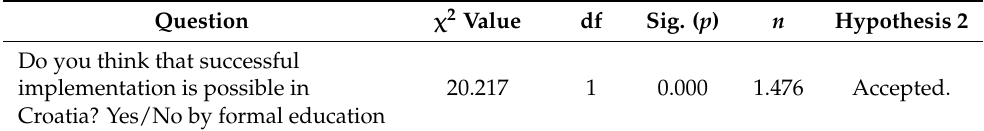
Table 3. Chi-Square Test results for the implementation of PPP models in